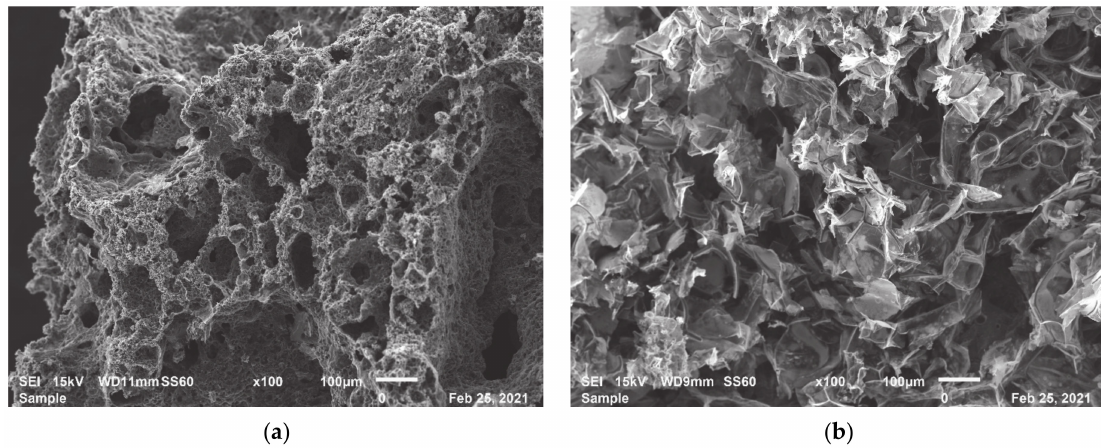
Figure 13. SEM image: ( a ) char of case 2; ( b ) char of case